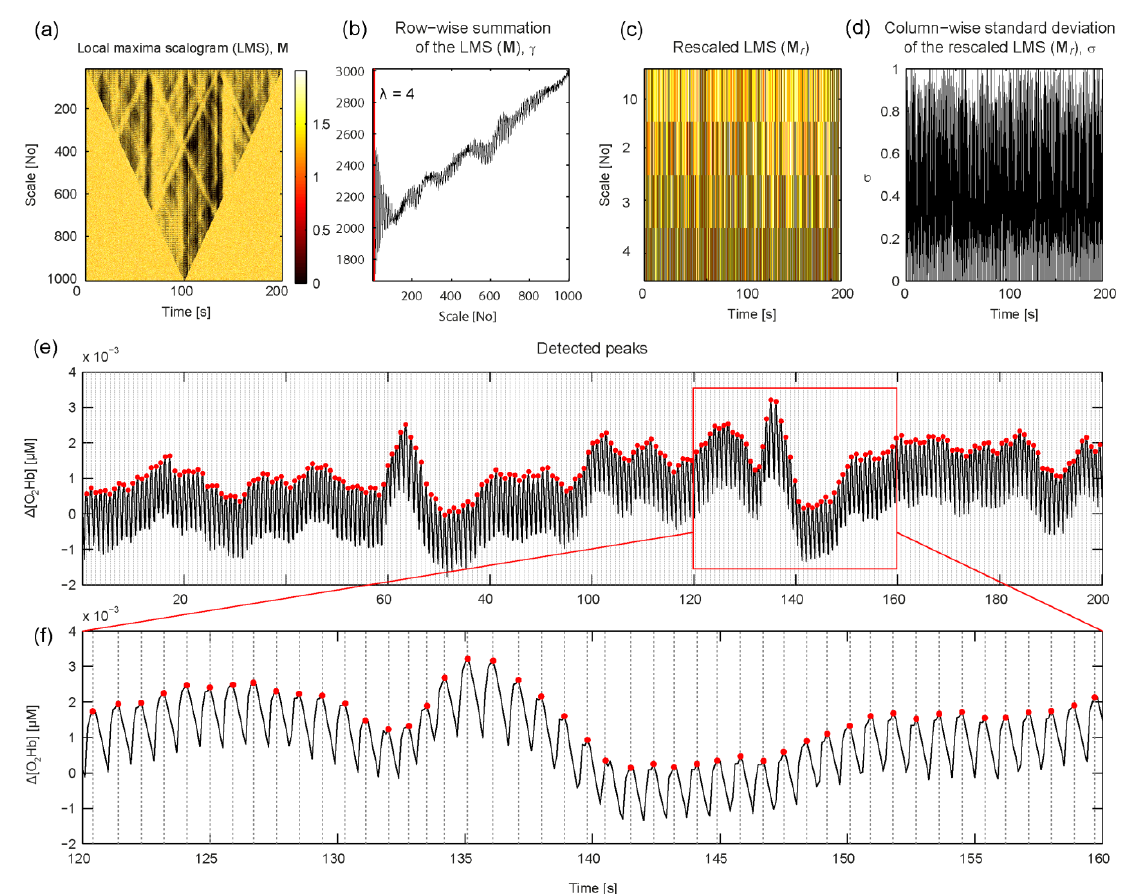
Hb] time series with 2